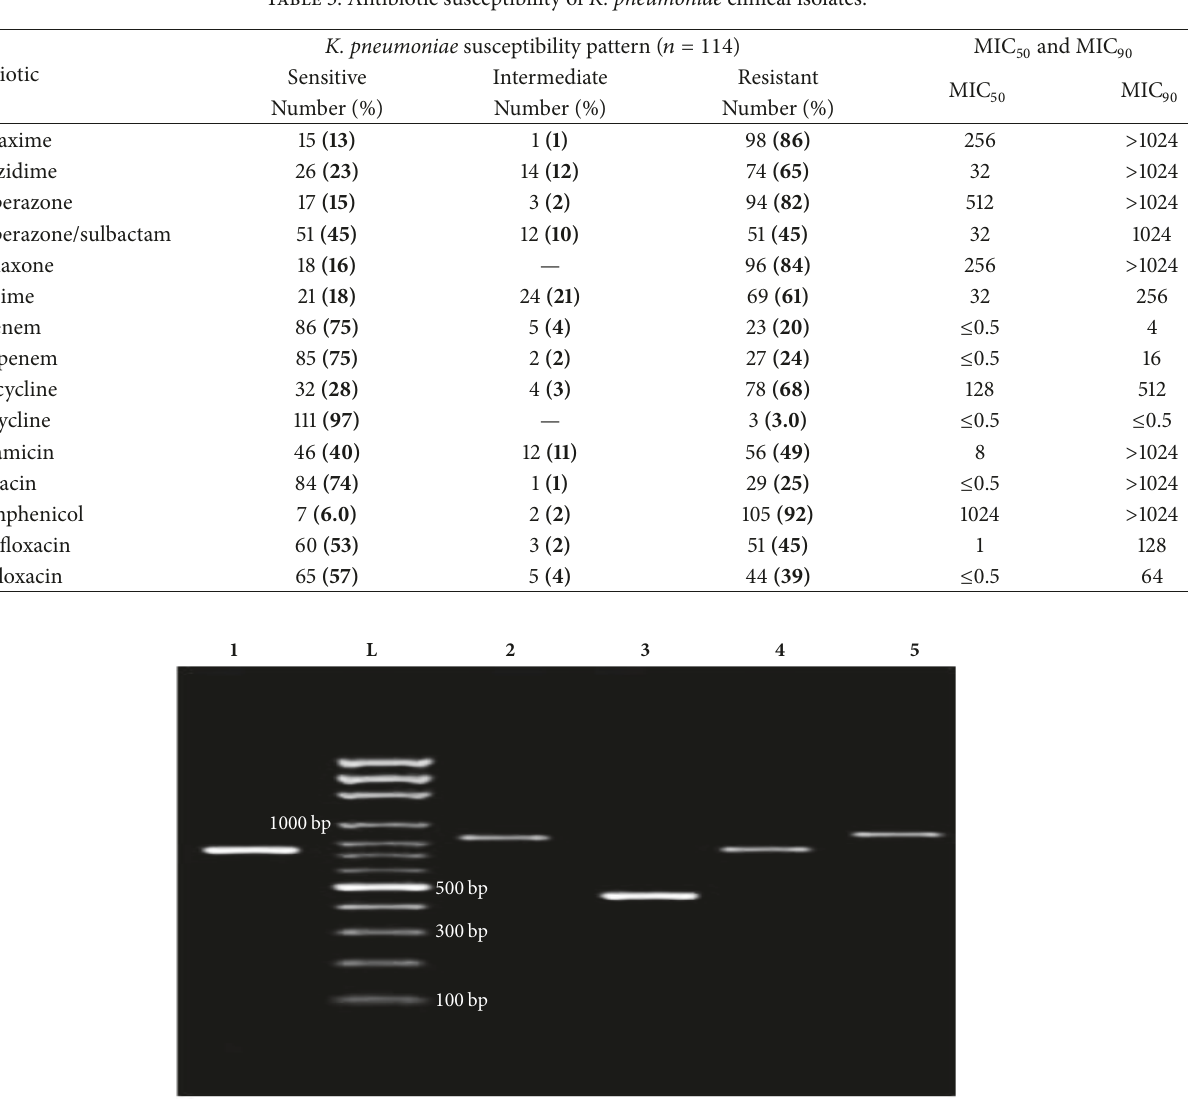
Figure 3: Representative PCR products of detected genes encoding AMEs. Lanes: (1) ant (3 󸀠󸀠 )-I ; (L) 100bp ladder; (2) armA ; (3) acc(6 󸀠 )-Ib ; (4) aph(3 󸀠 )-VI ; (5) acc(3-)-II